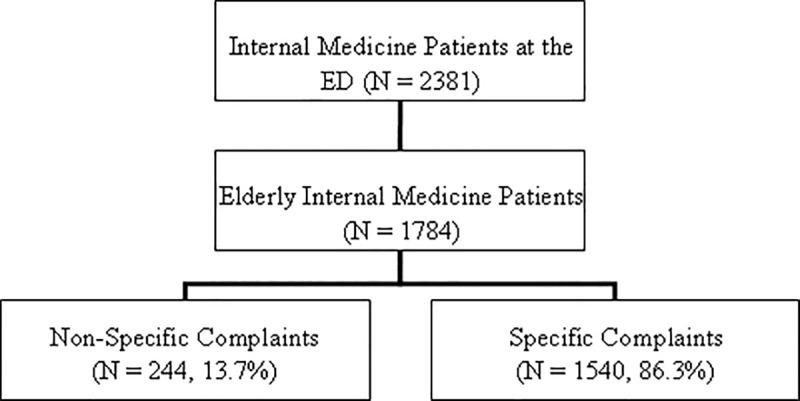
Flow chart of the study population.